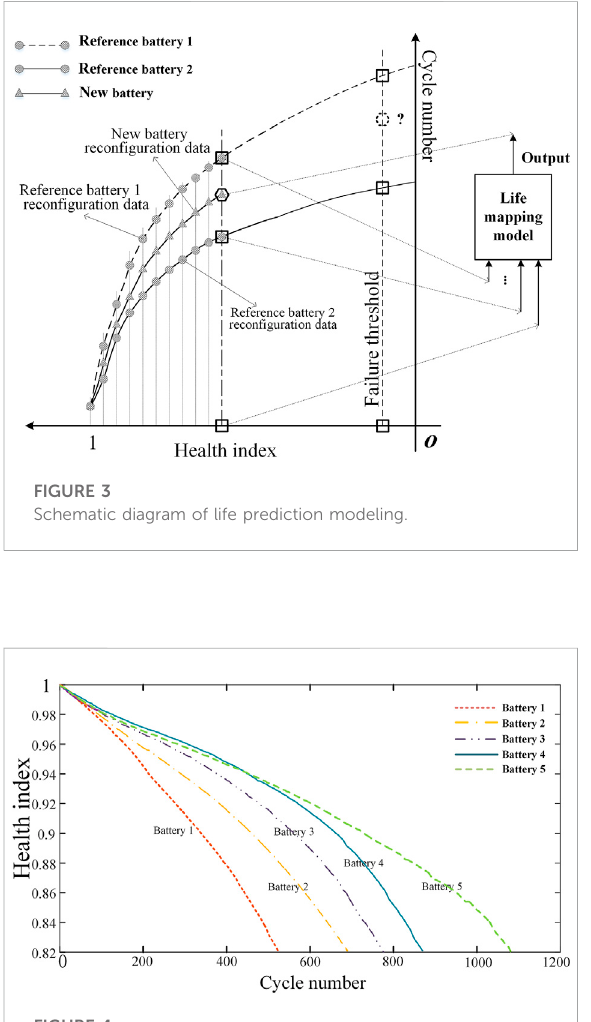
FIGURE 4 Lithium-ion battery health index degradation